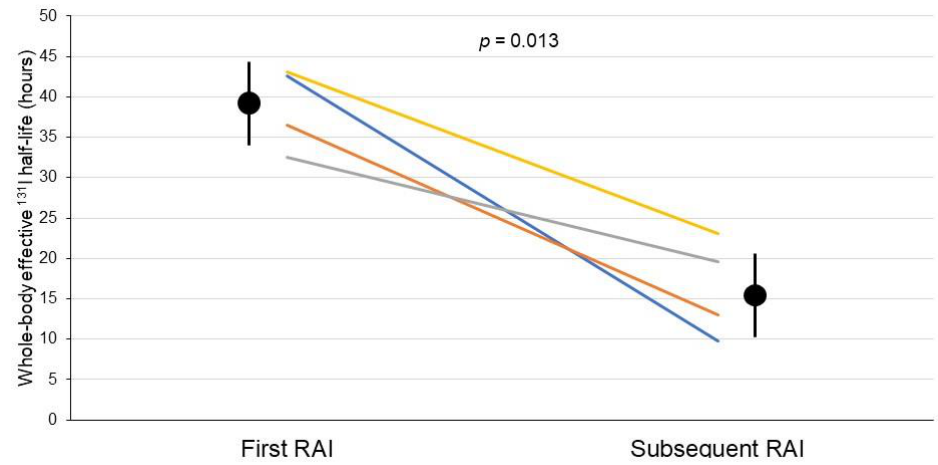
Figure 4. Effective 131 I half-life levels measured at the time of first RAI and during the subsequent RAI treatment in the 4 patients with low serum TSH levels at the first treatment course. A significant difference was observed between effective 131 I half-lives estimated at first and subsequent RAI treatment. Circles indicates effective 131 I half-life mean values, lines describe effective 131 I half-life range.